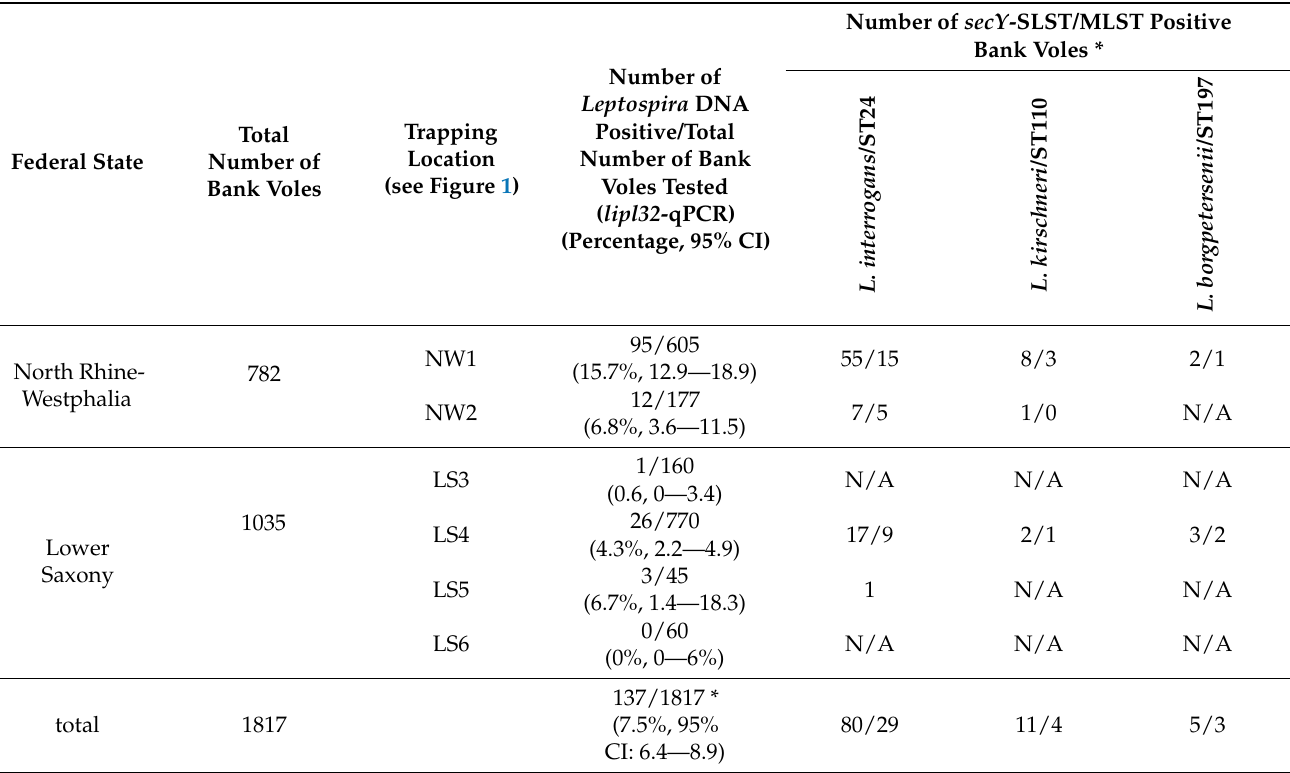
Table 1. Leptospira spp. prevalence and genomospecies distribution in bank voles captured in the years 2018 to